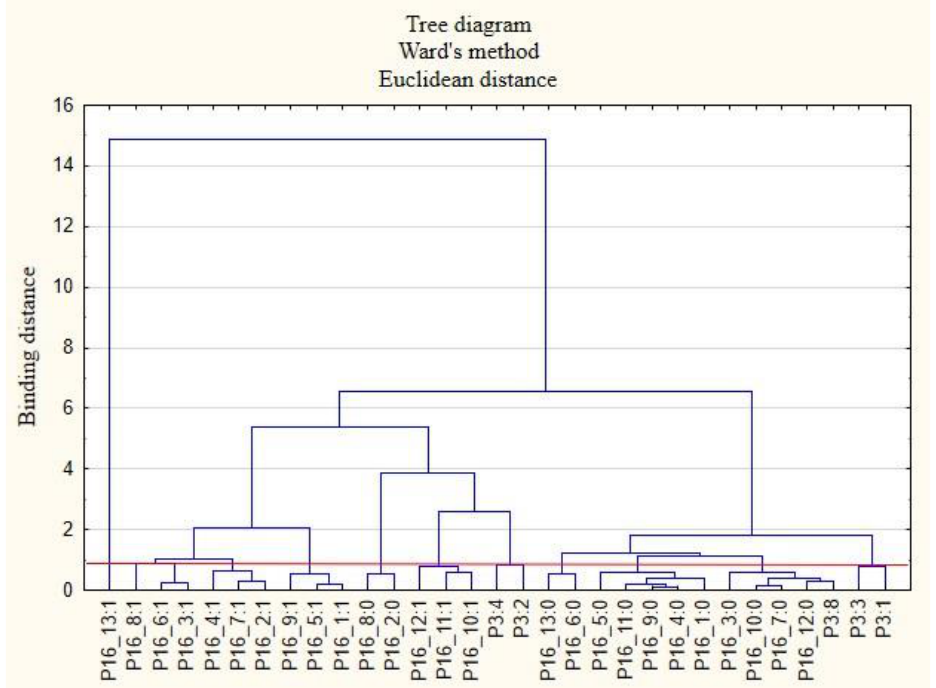
Figure 8. Diagram of hierarchical classification of variable categories: support that respondents